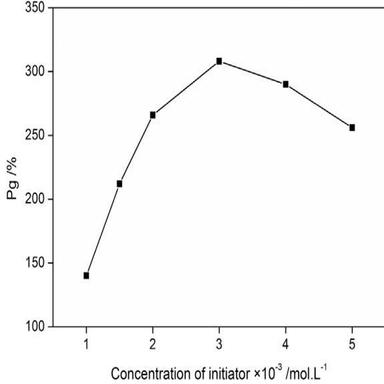
Effect of initiator concentration on the Pg of grafted copolymer: Weight of PG = 0.5 g, weight of AM = 1.5 g, t = 180 min, T = 50 °C.